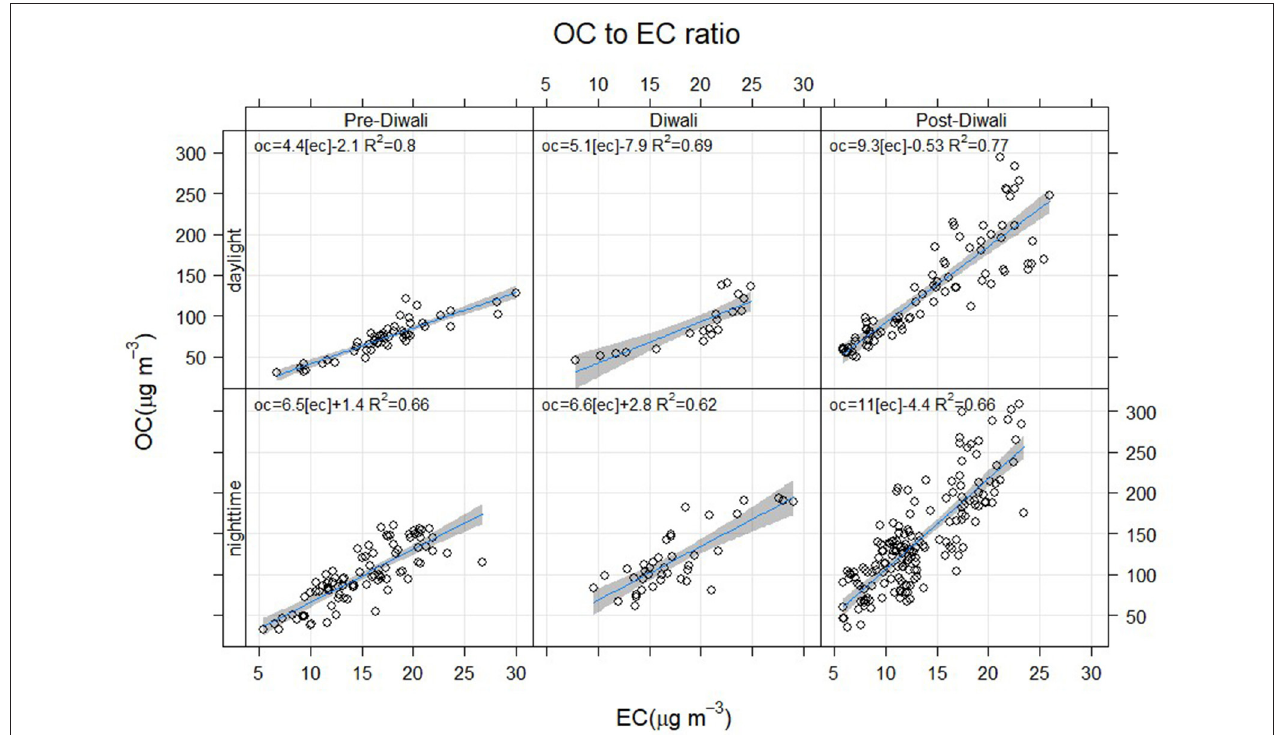
FIGURE 3 | Day and nighttime OC-to-EC ratio based on linear regression analysis ( p < 0.05) during Pre-Diwali, Diwali and Post-Diwali